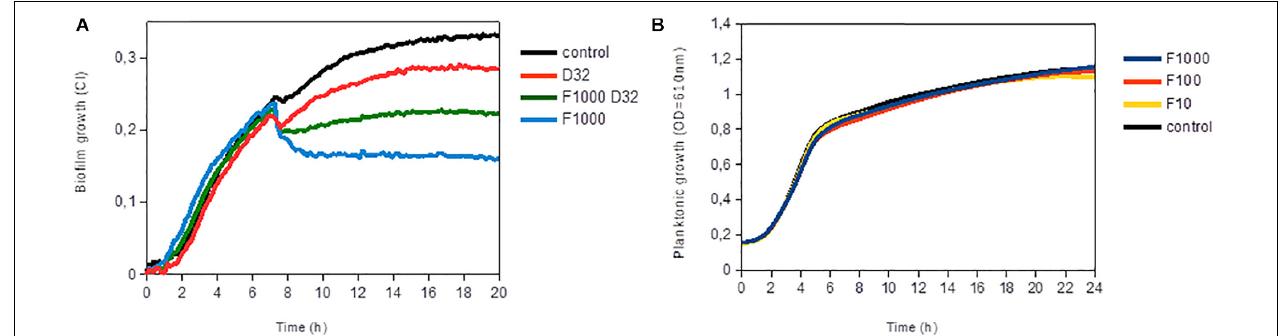
FIGURE 5 | Biofilm disruption by ficin alone and in combination with dalbavancin. (A) Biofilm treatment by ficin [marked as F (1,000, 100, and 10 mg/L)] and dalbavancin [marked as D (32 mg/L)], either alone or in combination (F1000 D32), in methicillin-resistant Staphylococcus aureus strain MRSA4. Ficin, dalbavancin, or both was added on established biofilms after 7 h of growth in an xCELLigence equipment. (B) Effect of ficin on planktonic bacterial growth, measured as optical density in a 96-well plate. Bacteria were grown on TSB supplemented with 0.25% glucose at 37 ◦ C. Data are the means of three replicates.